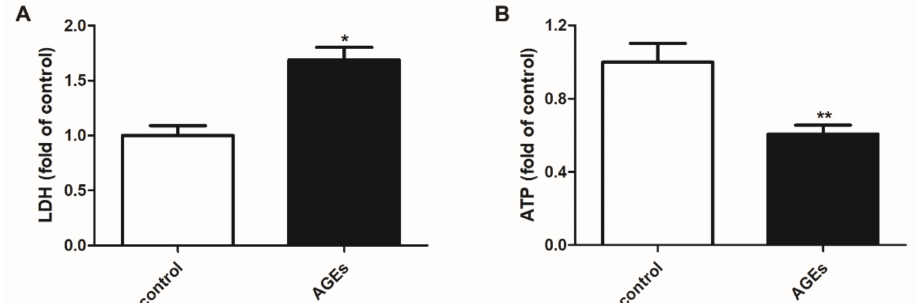
Figure 1. AGEs damaged cardiomyocytes. Cardiomyocytes were stimulated with AGEs (200 µ g/mL) for 24 h. ( A ) LDH release into the culture medium was detected by LDH Cytotoxicity Assay Kit. ( B ) Cellular ATP level was detected by Cell Titer-Lumi™ Luminescent Cell Viability Assay Kit. Plots represent the mean ± SEM; n = 6. Statistical significance: * p < 0.05, ** p < 0.01 compared with control.